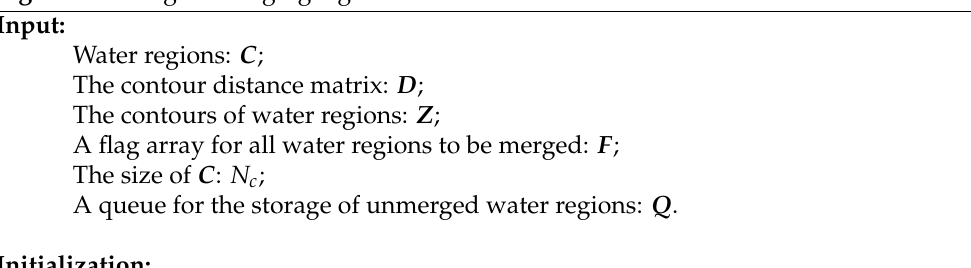
Algorithm 1 Region merging